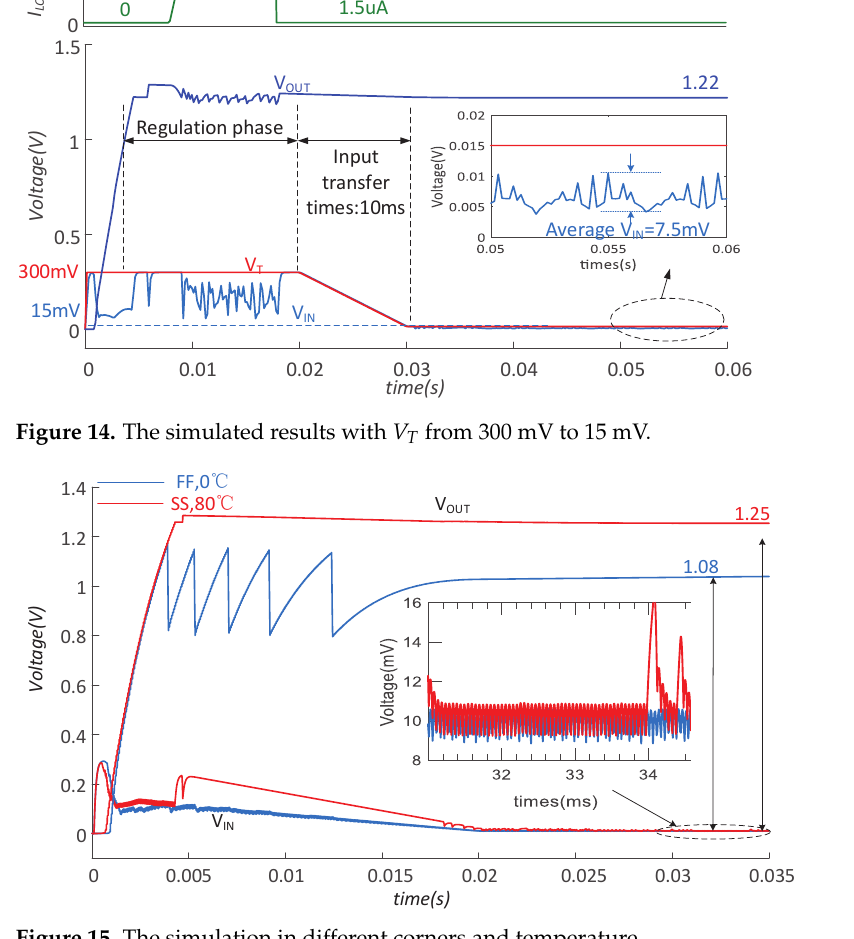
Figure 15. The simulation in different corners and temperature. Table 1. Startup voltage in different corners.